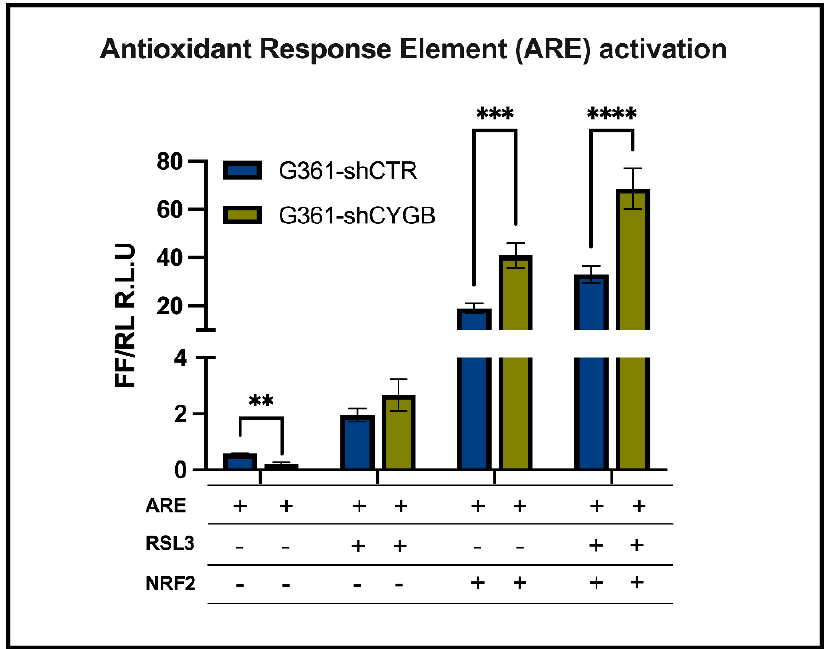
Figure 3. CYGB-dependent changes in antioxidant response element-driven luciferase activity. Binding of NRF2 to the antioxidant response element (ARE) in G361-shCTR and G361-shCYGB cells was assessed using an ARE-driven luciferase gene reporter assay. Cells were co-transfected with Renilla luciferase reporter vector to control for differences in transfection efficiency and extract preparation. Reporter activities were expressed as relative firefly/ Renilla luciferase activities (R.L.U.). Luciferase reporter activity was measured after 6 h under basal conditions or upon 10 µ M RSL3 treatment in the presence or absence of NRF2 overexpression in G361-shCTR and G361-shCYGB cells. Results are depicted as the mean with S.E.M. of six independent experiments (n = 6). Two-way ANOVA (** p ≤ 0.01; *** p ≤ 0.001; **** p ≤